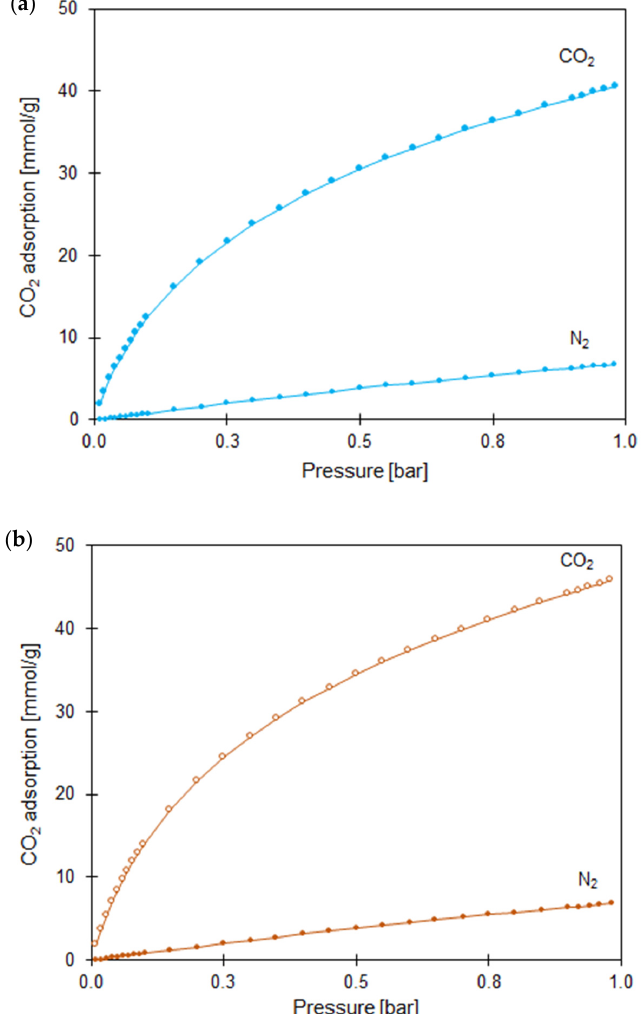
Figure 11. A comparison of single component CO 2 and N 2 adsorption isotherms for ( a ) 3.00 CS/TiO 2 and ( b ) 4.00 CS/ZnO samples.